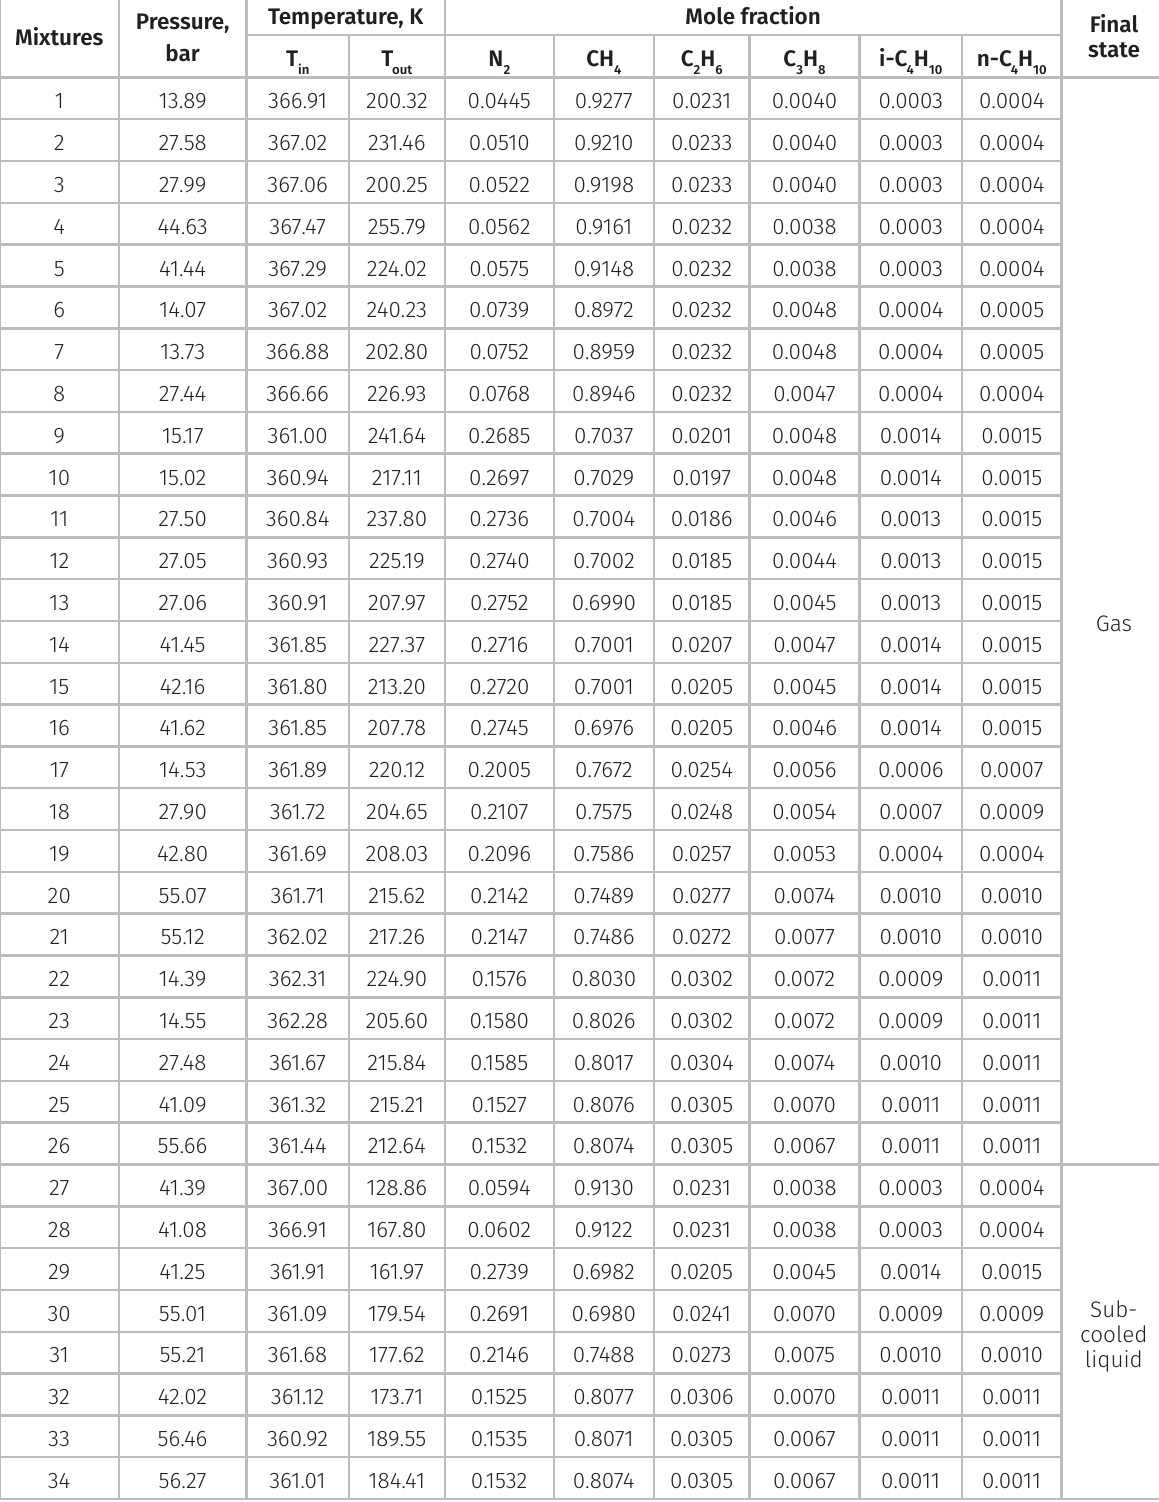
Table V. Composition, pressure and temperature range of the mixtures used for enthalpy variation prediction.